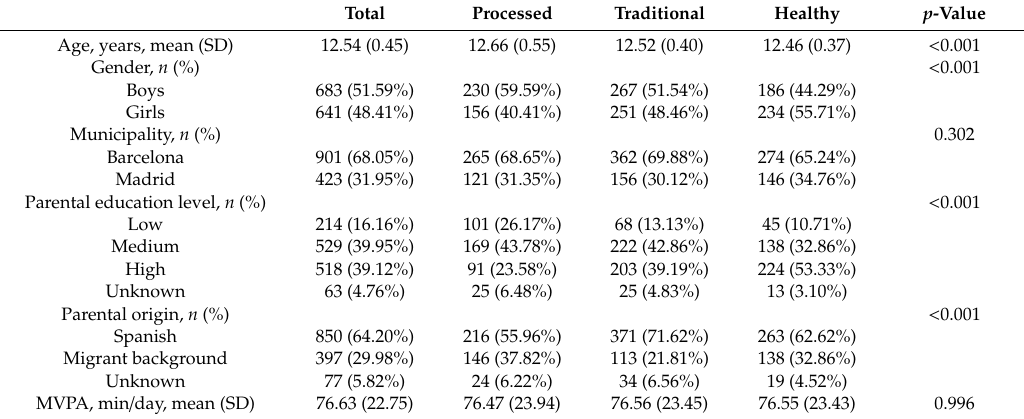
Table 3. Adolescent and family characteristics in the total population and stratified by dietary pattern cluster. Total Processed Traditional Healthy p -Value Age, years, mean (SD)